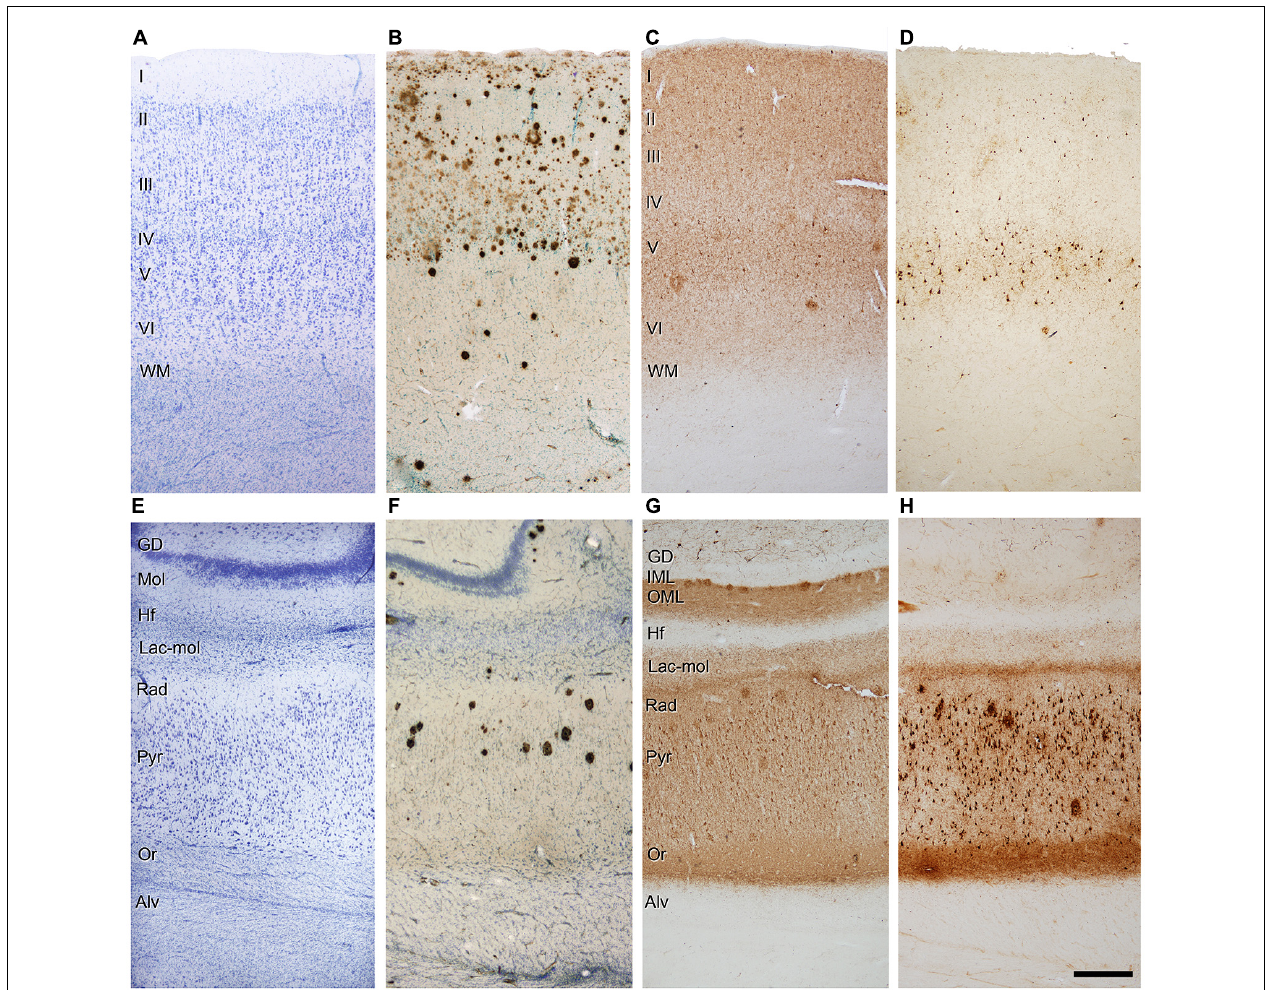
FIGURE 4 | Photomicrographs of sections from the parahippocampal cortex (A − D) and CA1 region (E − H) of patient P9 stained for Nissl (A,E), A β /Nissl (B,F), PHF-tau AT8 (C,G), and PHF-tau PHF-1 (D,H). Alv, alveus; DG, dentate gyrus; Hf, hippocampal fissure; IML, inner molecular layer; Lac-mol,